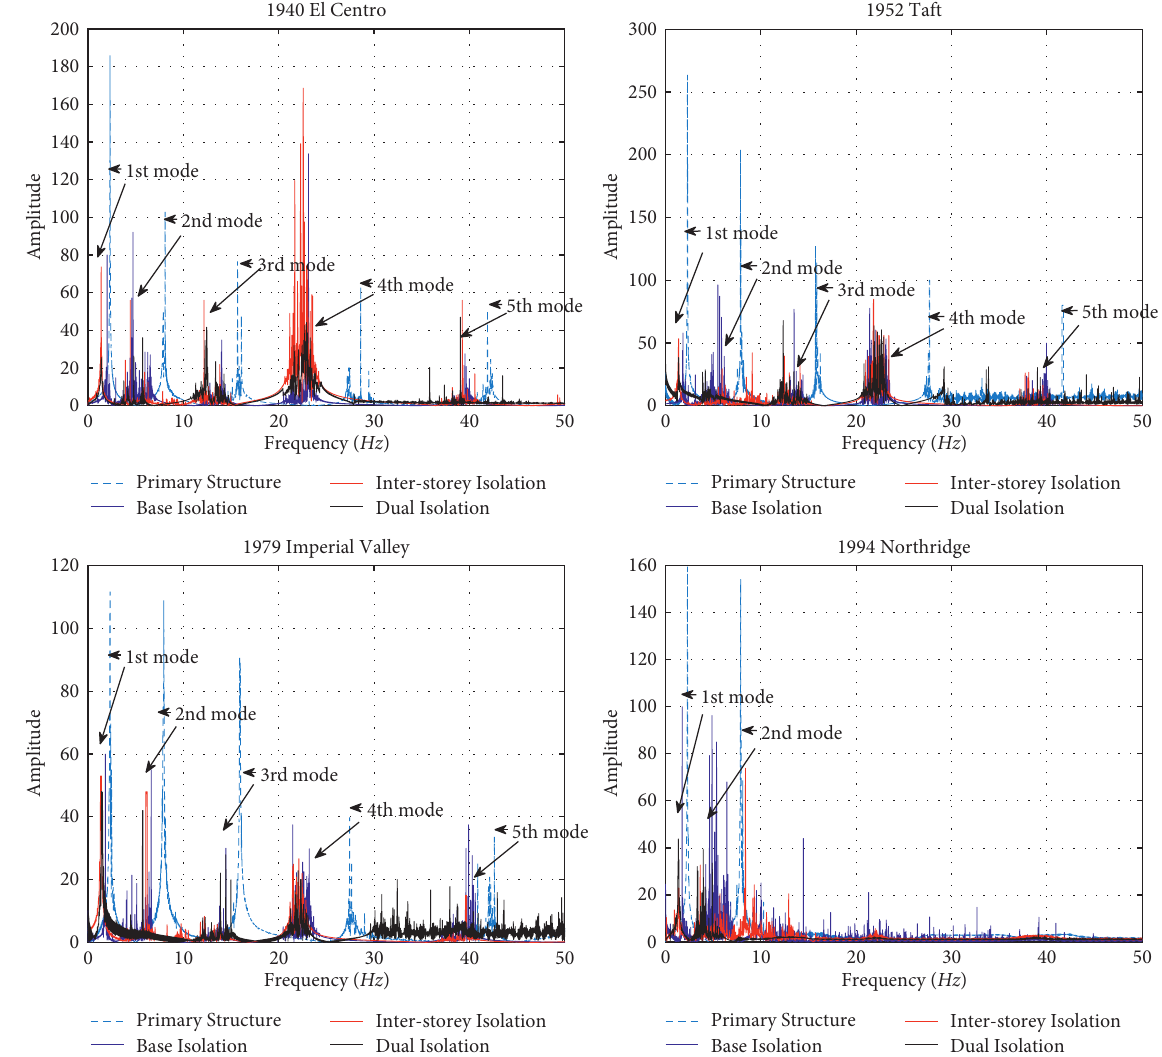
Figure 12: Top acceleration transfer function